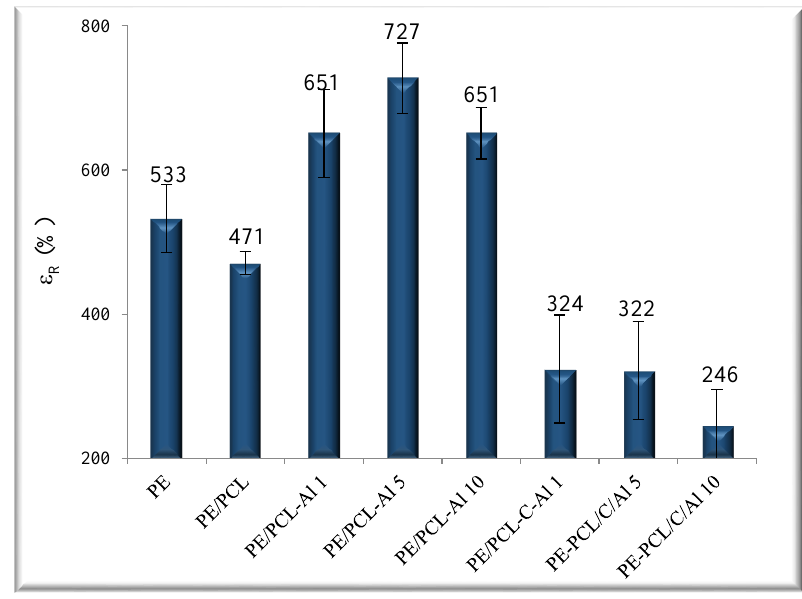
Figure 4. Elongation at break (ε) of PE/PCL bilayer films .